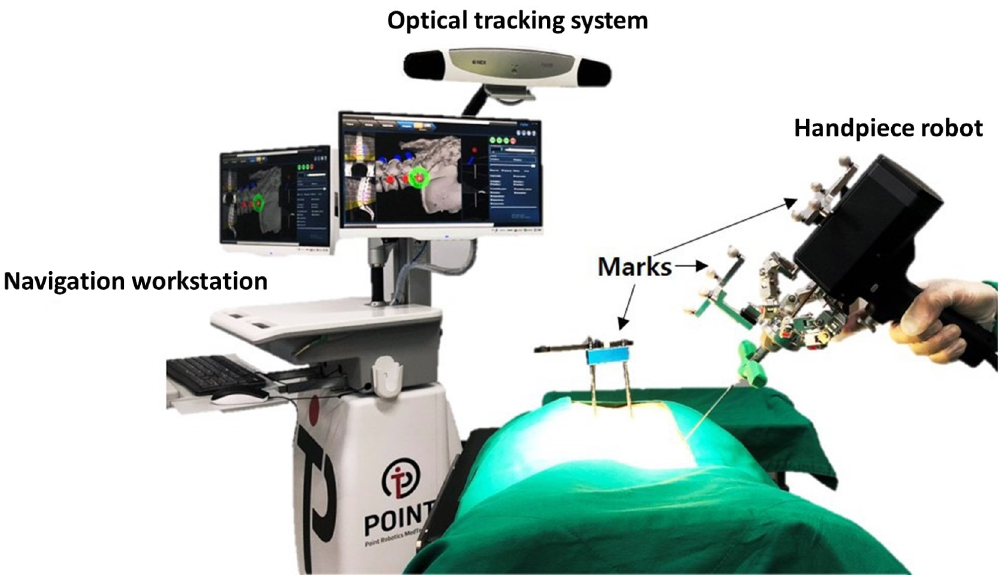
Fig 1. Point spine navigation system